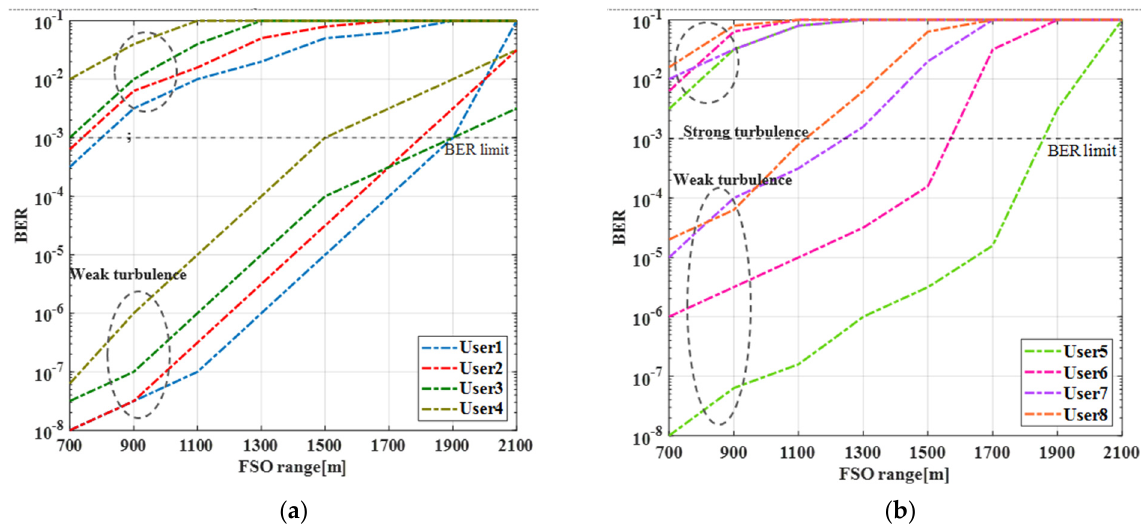
Figure 6. Measured BER under log-normal turbulence modeling. ( a ) Users 1 to 4 operating at Donut mode 0, ( b ) users 5 to 8 operating at Donut mode 1.